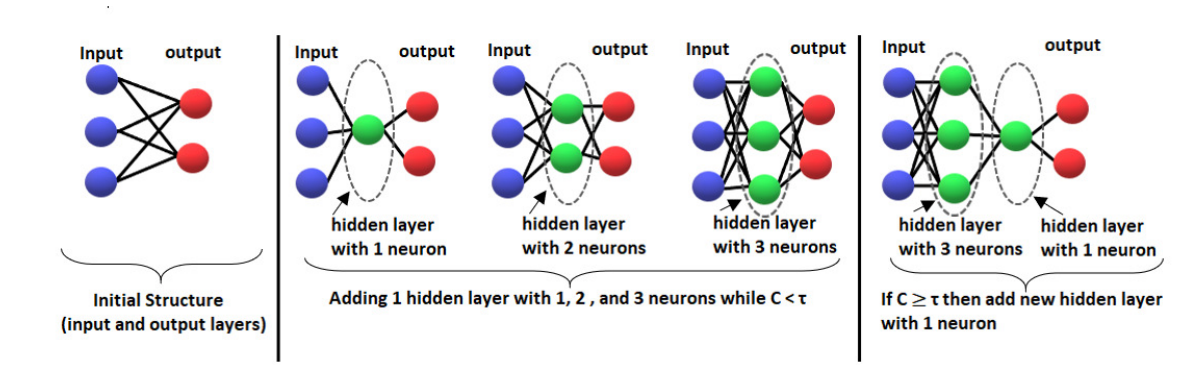
Figure 5. Steps of CCG-DLNN